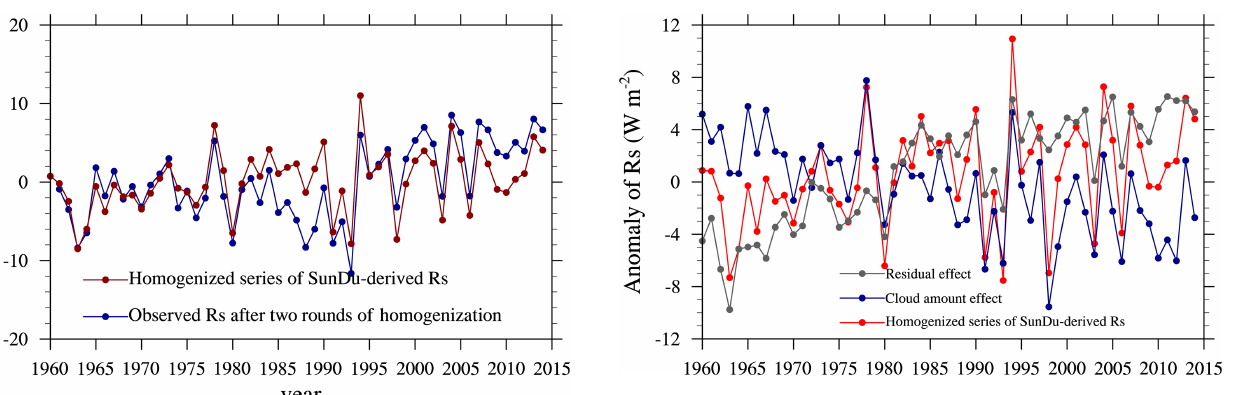
Figure 13. Area-averaged anomalies of homogenized SunDu- derived R s (red line) over Japan. The cloud cover radiative effect (CCRE, blue line) was denoted as the change in R s produced by a change in cloud cover and calculated following Eq. (4) by ob- served cloud amounts and the cloud radiative effect (CRE) from the CERES satellite retrieval. The residual effect (grey line) was ob- tained by removing the cloud cover radiative effect (CCRE) from the homogenized SunDu-derived R s